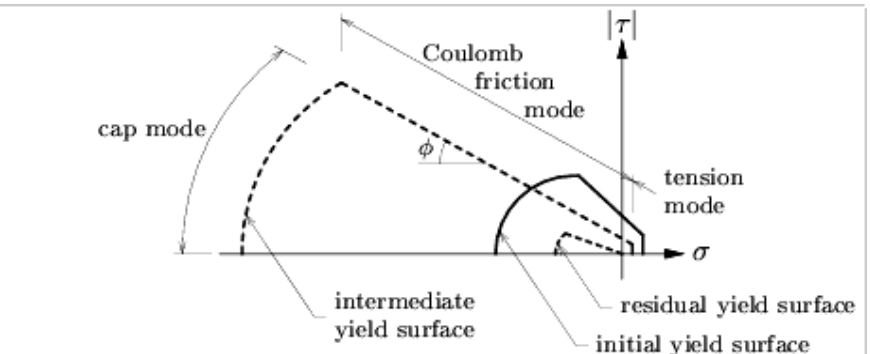
Figure 8. Constitutive model for masonry interfaces [22] adapted from Haach